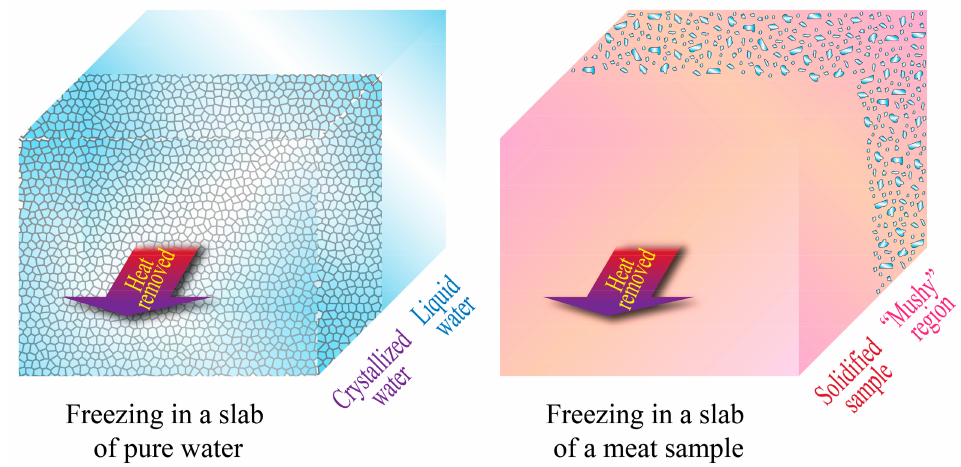
Figure 2. Unidimensional heat transfer and freezing in slabs of pure water and a meat sample. Adapted from Datta